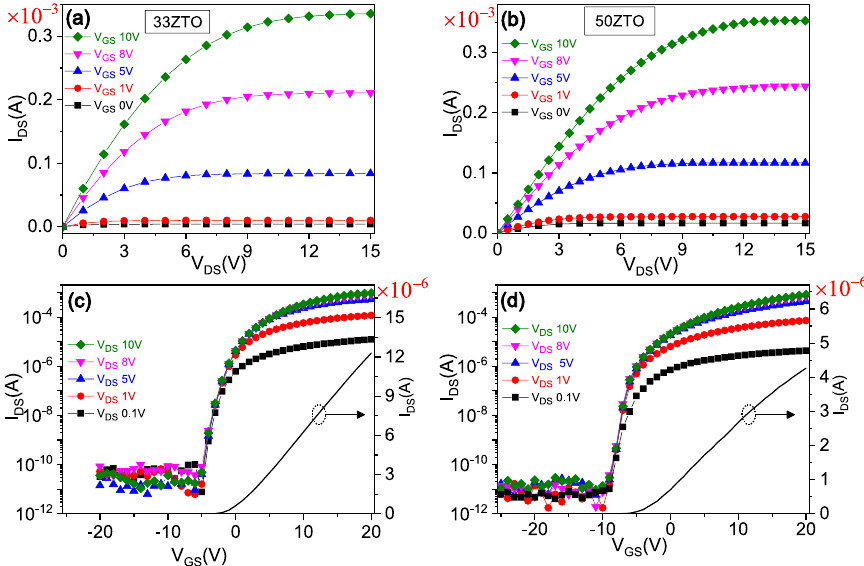
Figure 1. The output characteristics (I DS vs. V DS ) of ZTO TFTs for the sample ( a ) 33ZTO and ( b ) 50ZTO measured at different V GS . In ( c ) and ( d ), the transfer characteristics (I DS vs. V GS ) of ZTO thinfilm transistors for the sample 33ZTO and 50ZTO, respectively. In both the TFTs, active semiconductor channel W/L ratio was fixed to 38.